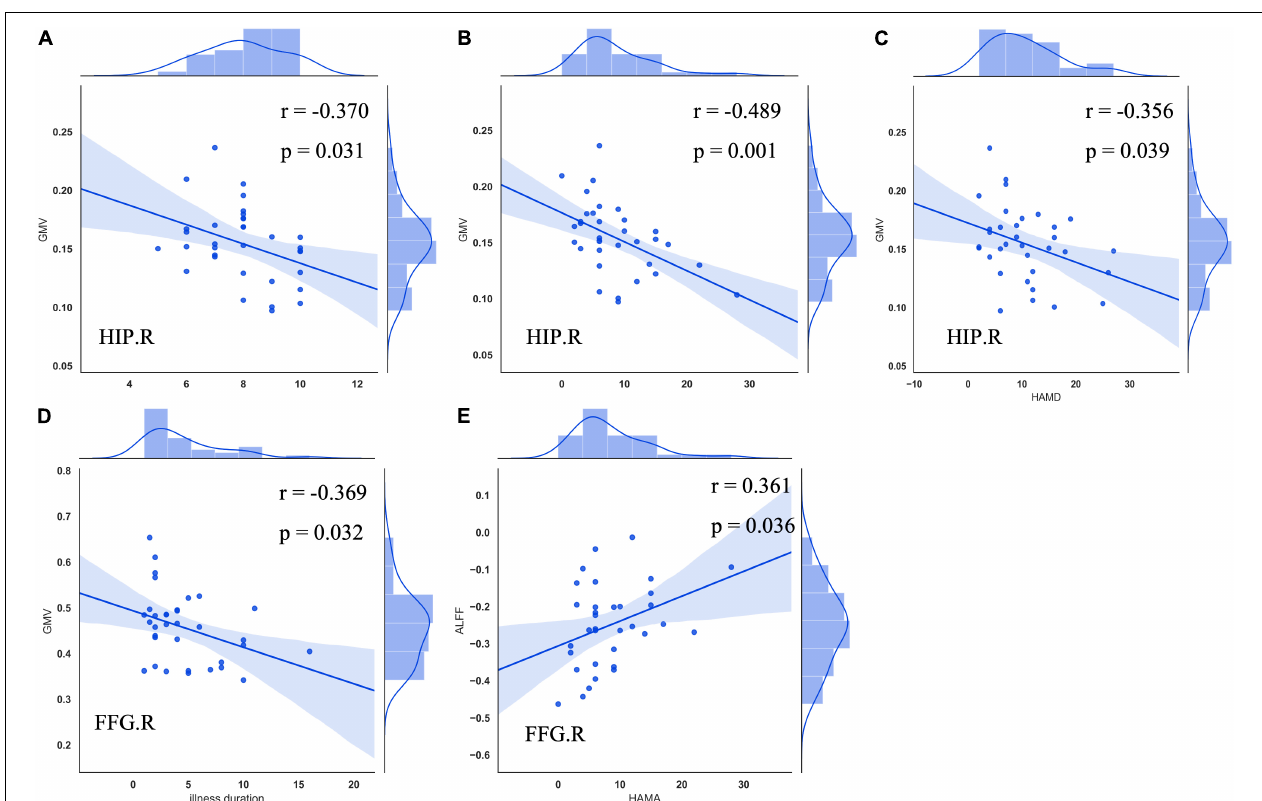
FIGURE 4 | Correlation between GMV, zALFF alterations, and clinical variables in patients with CTN. GMV in the right hippocampus was negatively associated with VAS (A) , HAMA (B) , and HAMD (C) scores of patients with CTN. GMV in the right FFG was negatively correlated with illness duration (D) . Increased zALFF in the right FFG was positively correlated with HAMA score of the patients with CTN (E) . GMV, gray matter volume; ALFF, amplitude of low-frequency fluctuation; CTN, classic trigeminal neuralgia; HIP, hippocampus; VAS, visual analog scale; HAMA, Hamilton Anxiety Rating Scale; HAMD, Hamilton Depression Rating Scale; FFG, fusiform